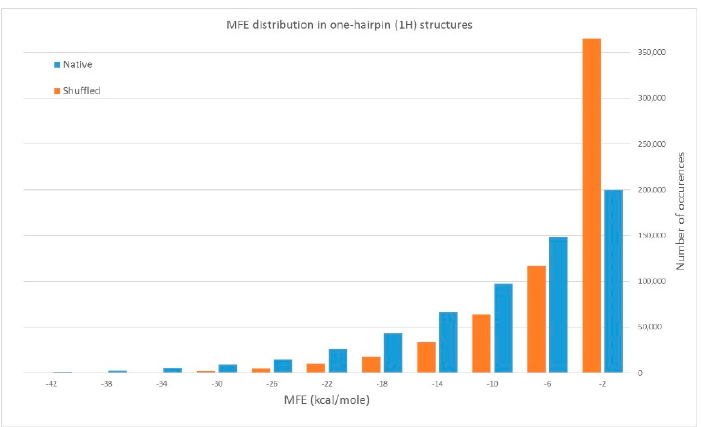
Figure 6. The mean free energy (MFE) distribution of all one-hairpin (1H) structures in our dataset comparing native and shuffled sequences. Reported p -value (see text) is less than 0.0001.